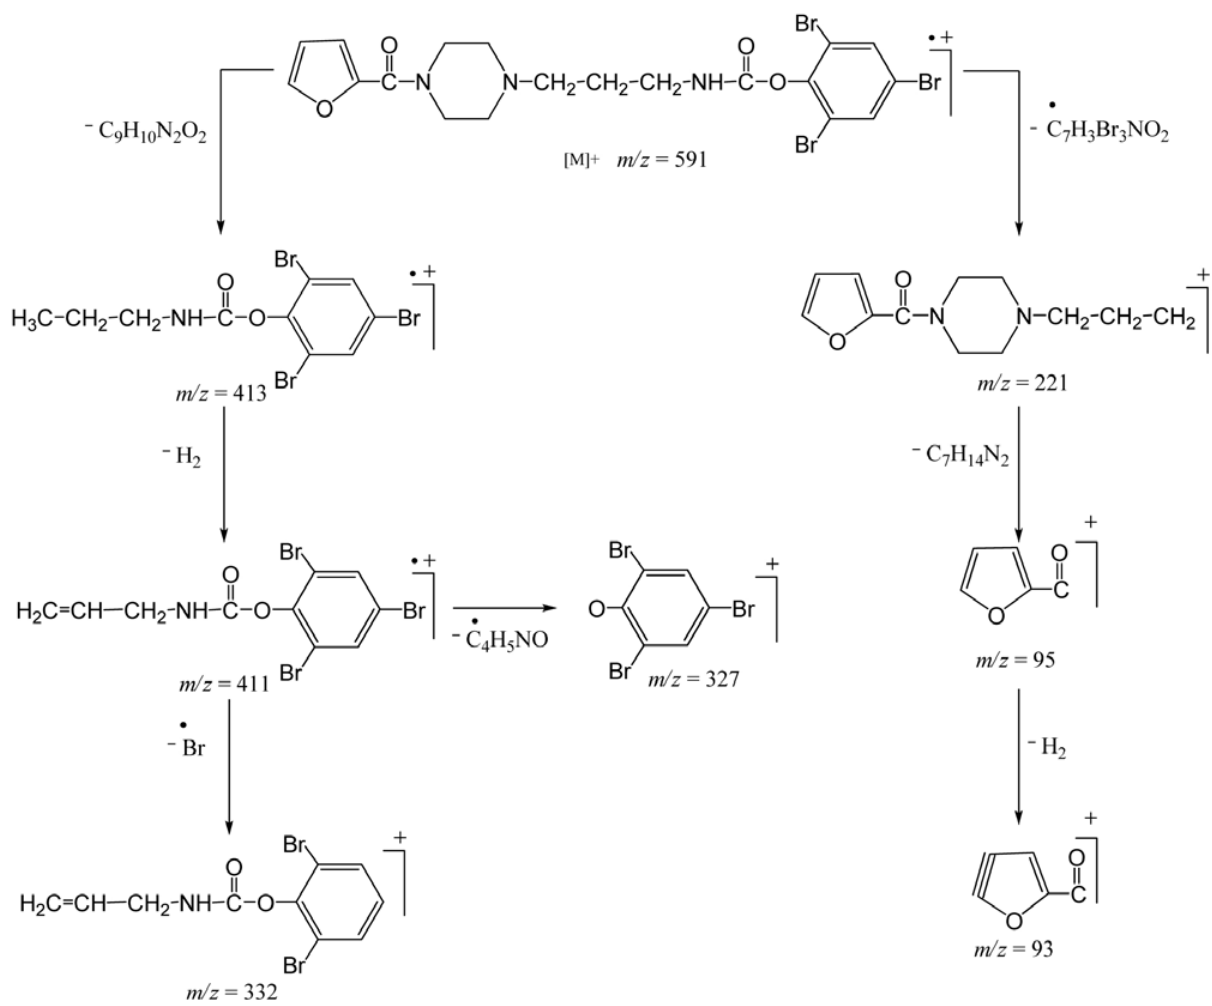
Fig. 2 . Suggested mass fragmentation pattern of 2,4,6-tribromophenyl 3- [ 4-(2-furoyl)-1-piperazinyl ] propylcarbamate ( 16